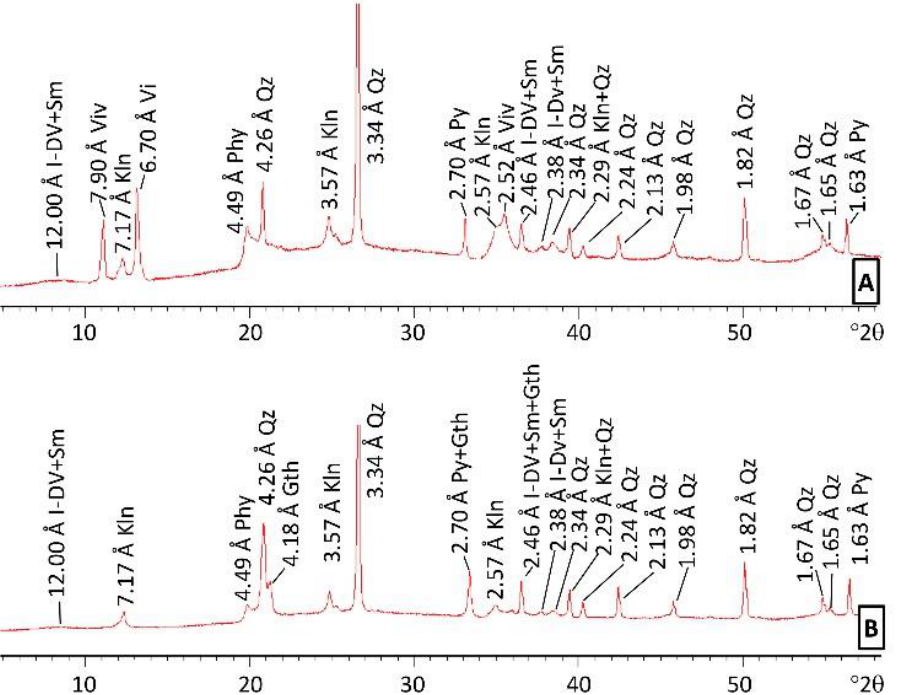
Figure 2. Selected XRD patterns from sediments of La Playa dam: ( A ) permanently flooded sediments (sample LP7); ( B ) periodically emerged sediments (sample LP8). I-DV: illite-smectite mixed layers; Sm: smectite; Kln: kaolinite; Viv: vivianite; Phy: phyllosilicates; Qz: quartz; Py: pyrite; Gth: